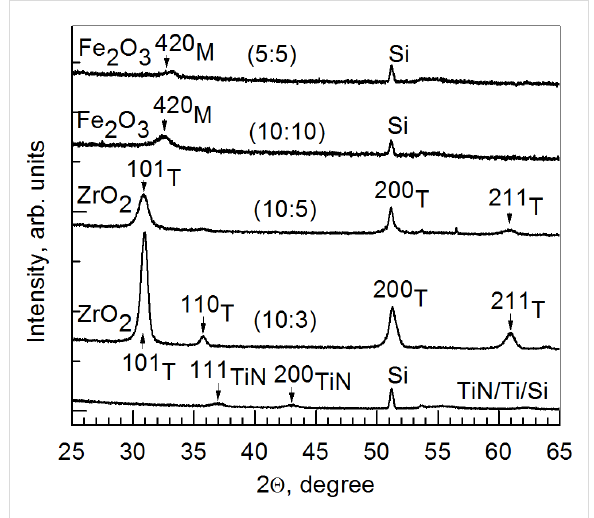
Figure 2: Grazing incidence X-ray diffraction (XRD) patterns for ZrO 2 /Fe 2 O 3 films deposited on TiN with ZrO 2 /Fe 2 O 3 cycle ratios and thickness indicated in the labels. The Miller indices are attributed to corresponding monoclinic (M) and tetragonal (T) phases of pure Fe 2 O 3 and ZrO 2 , respectively. The cation ratio of Zr/Fe in the films deposited on TiN with cycle ratios of 5:5, 10:10, 10:5 and 10:3 were 0.15, 1.7, 2.0 and 10,